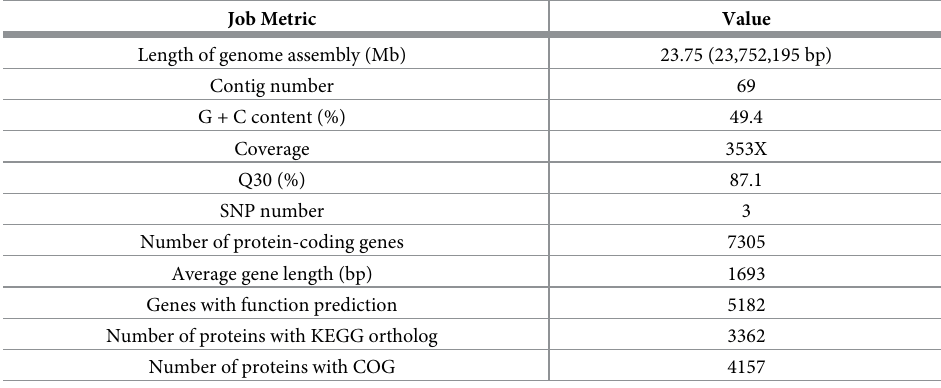
Table 1. M . purpureus CSU-M183 genome general